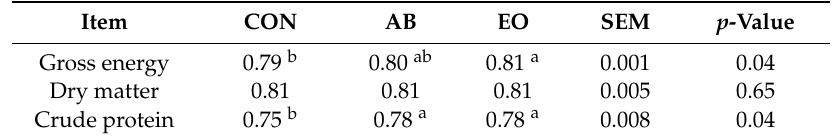
Table 4. E ff ects of essential oil supplementation on apparent total tract digestibility of nutrients in weaned piglets on day 28 in the experiment 1 . Item CON AB EO SEM p -Value